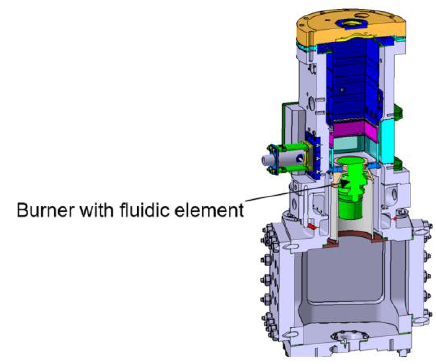
Figure 4. Schematic of the single sector combustor used for optical measurements.